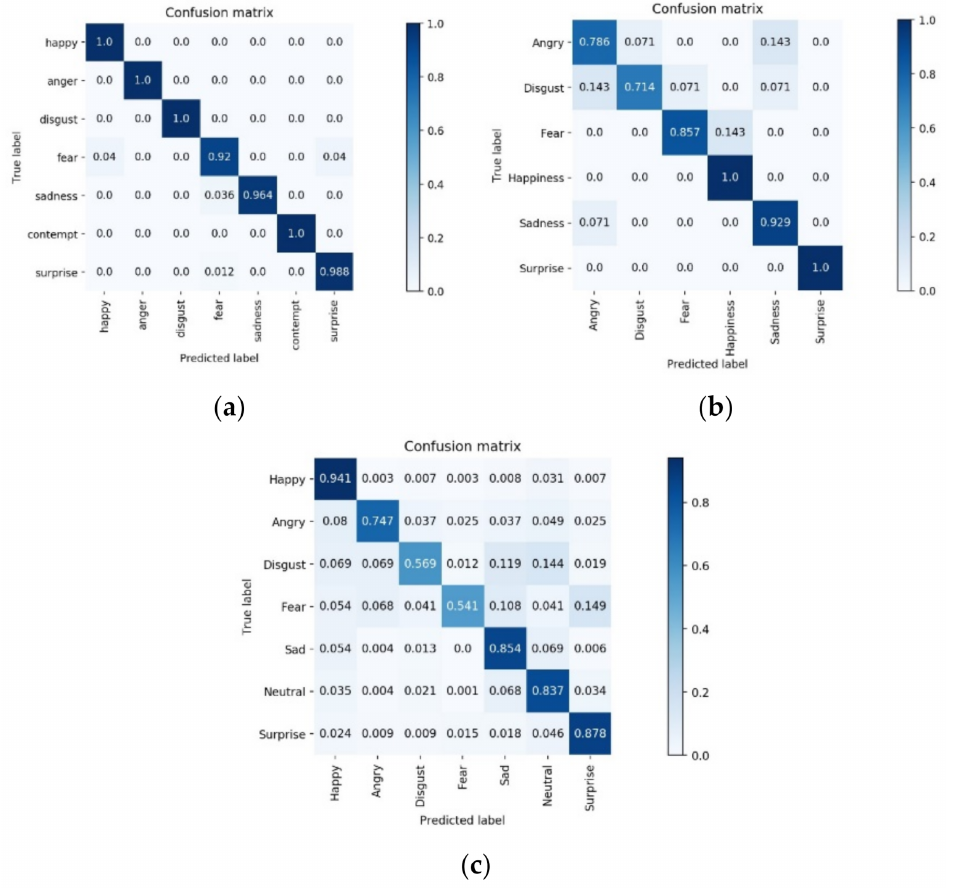
Figure 5. Confusion matrix of the network on the ( a ) CK+, ( b ) Oulu–CASIA, and ( c ) RAF–DB datasets. The ROC curve is a general indicator of network classification performance. The coordinate represents the true positive rate. The ROC generally uses the area under the